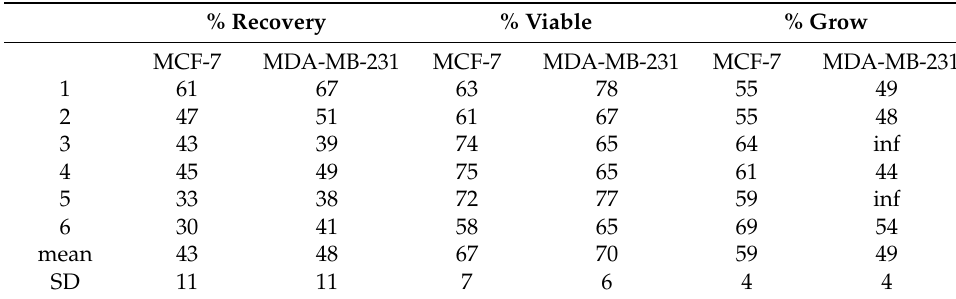
Table 1. Recovery and viability after processing 7.5 mL EDTA blood spiked with ~100 MCF-7 and ~100 MDA-MB-231 cells. After 2 days of cell culture the percentage of cells that showed cell growth was determined. In two of the experiments an infection was observed (inf).